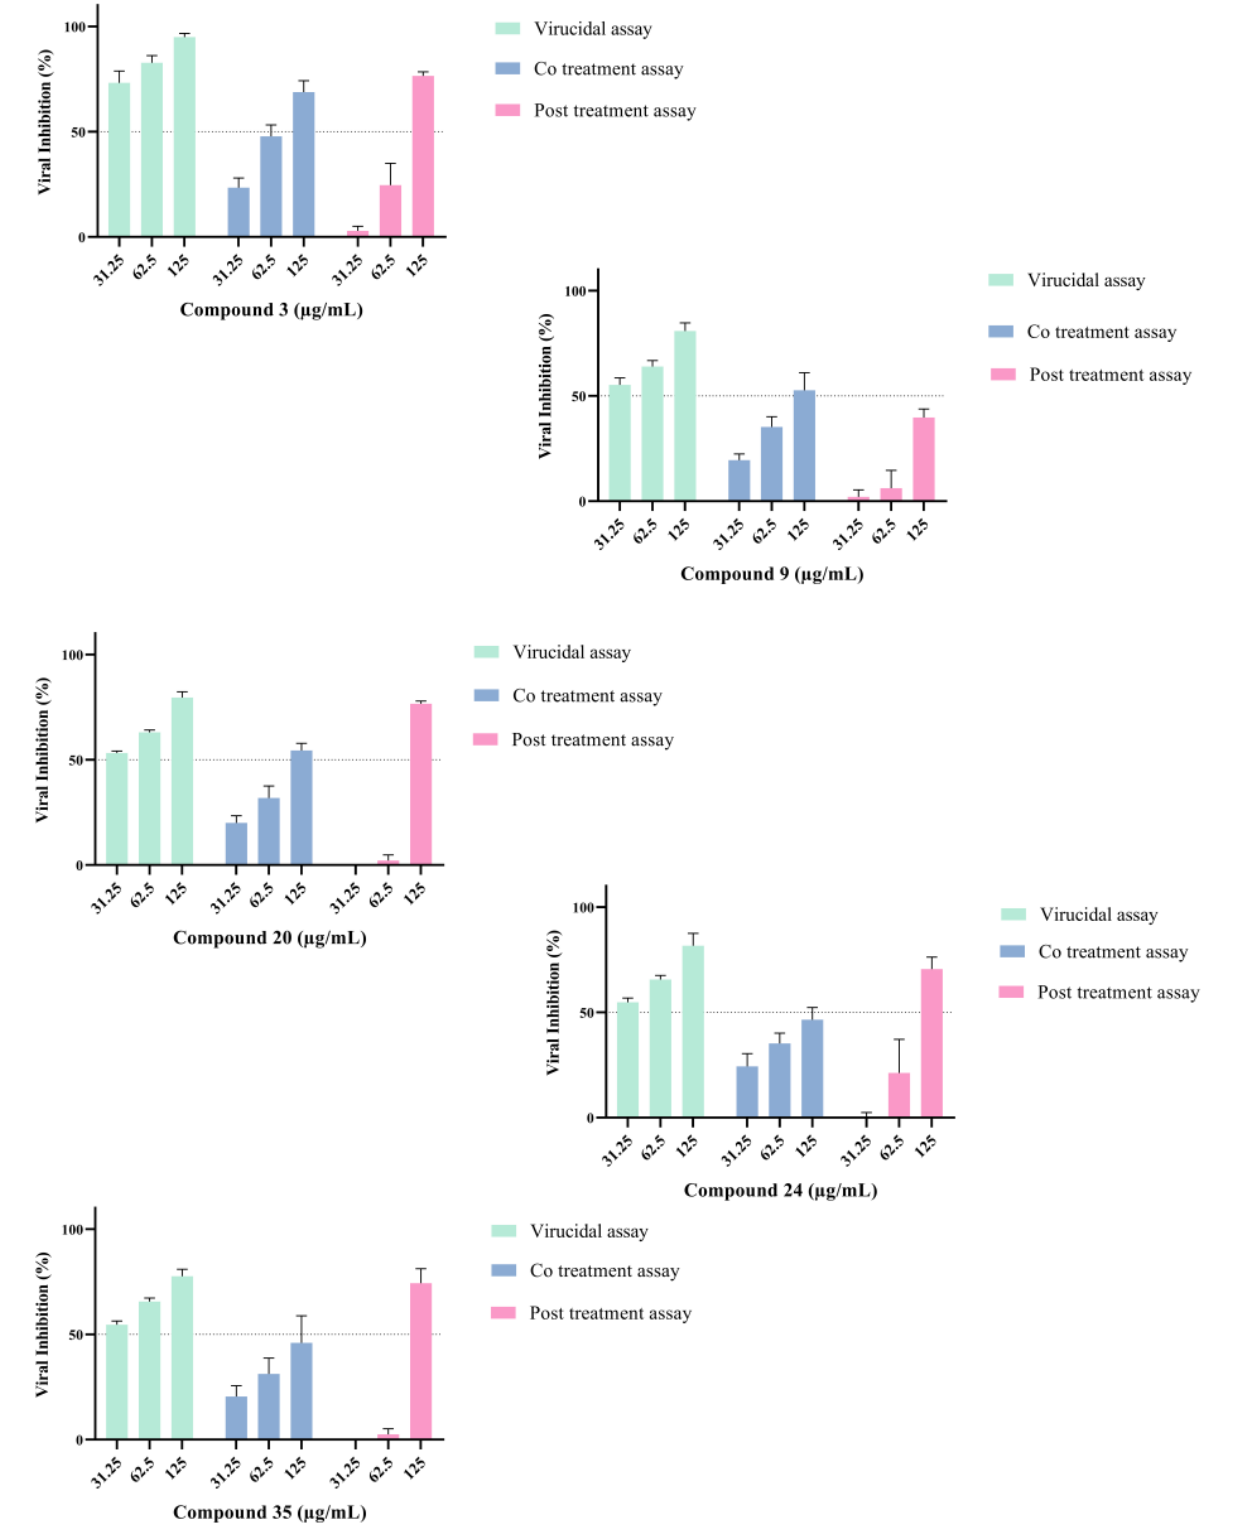
Figure 4. Percentage of viral inhibition under different experimental conditions. The inhibitory effect of the five compounds on CHIKV replication was assessed in a dose-dependent manner, with a constant challenge of 50 PFU per well. Data represented % of virus inhibition compared to untreated control as mean ± SD ( n = 3), each time by triplicate.